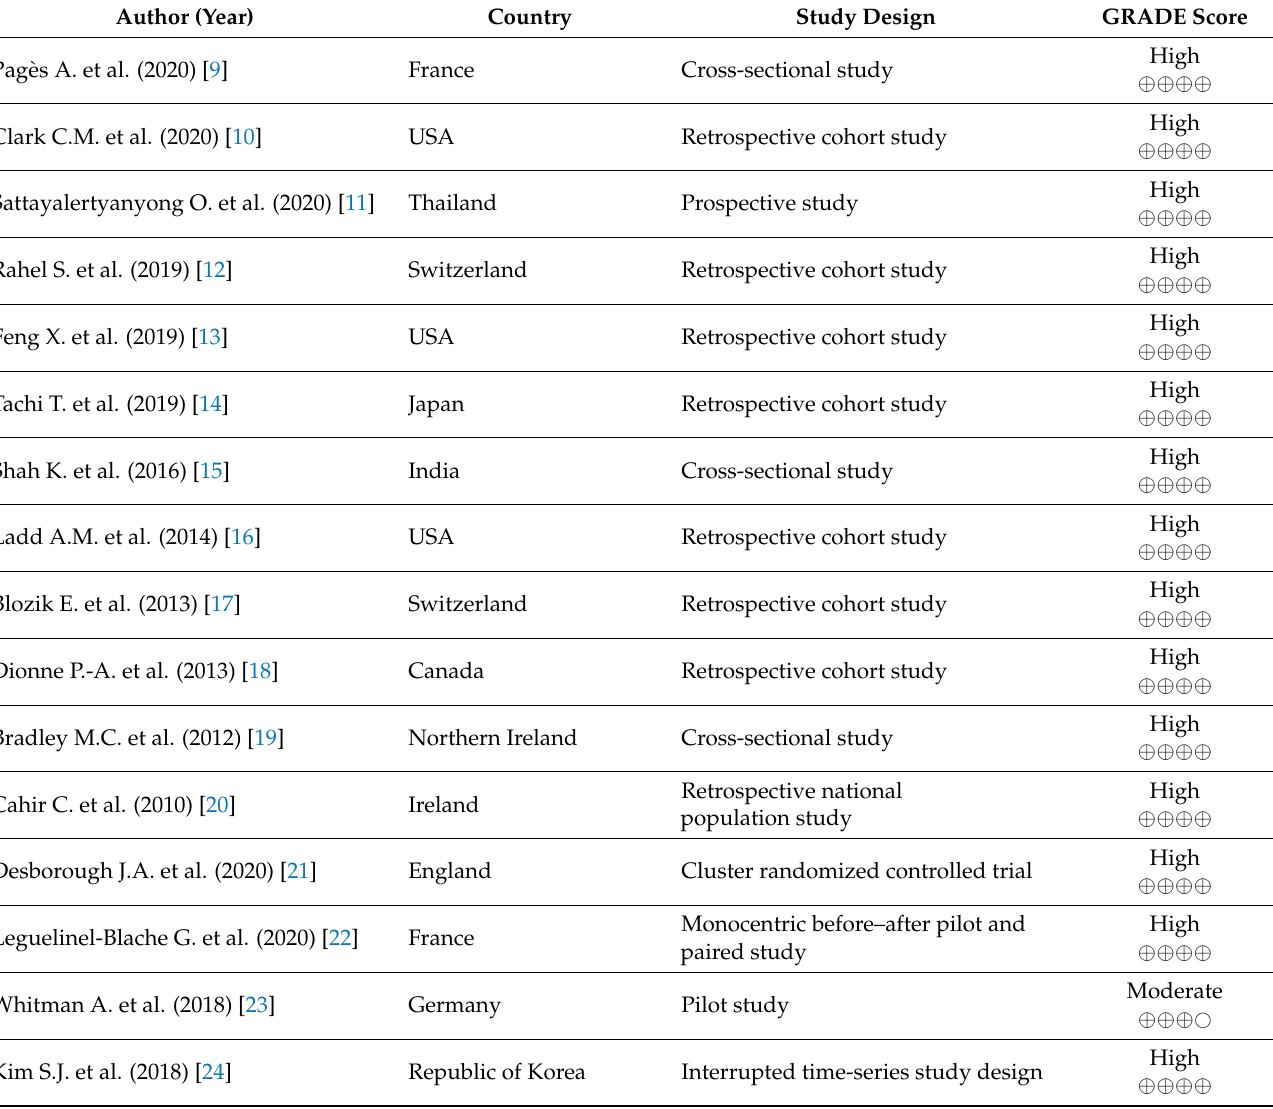
Table A2. Quality Appraisal of the included studies ( n =